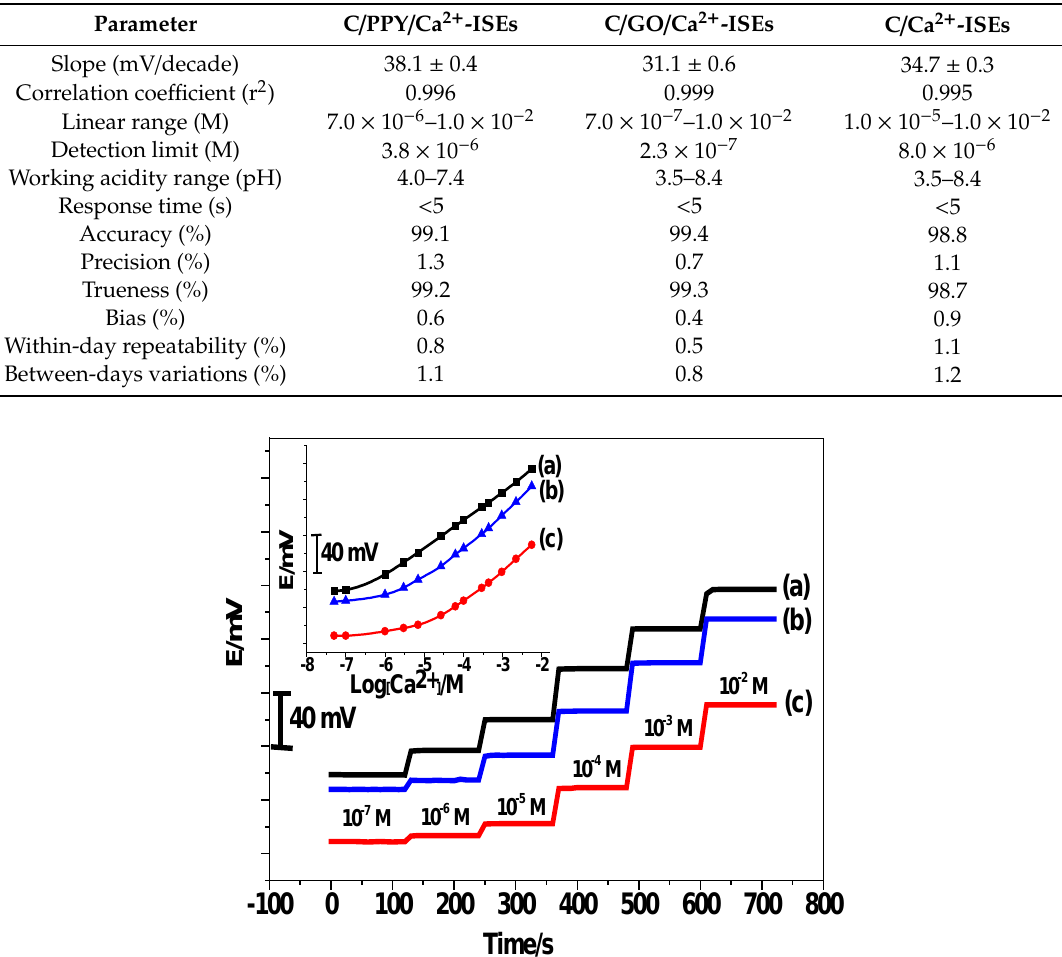
Figure 1. Calibration plots of the proposed calcium-solid contact selective electrodes: ( a ) C/GO/Ca 2+ -ISEs; ( b ) C/PPY/Ca 2+ -ISEs; and ( c ) C/Ca 2+ -ISEs.